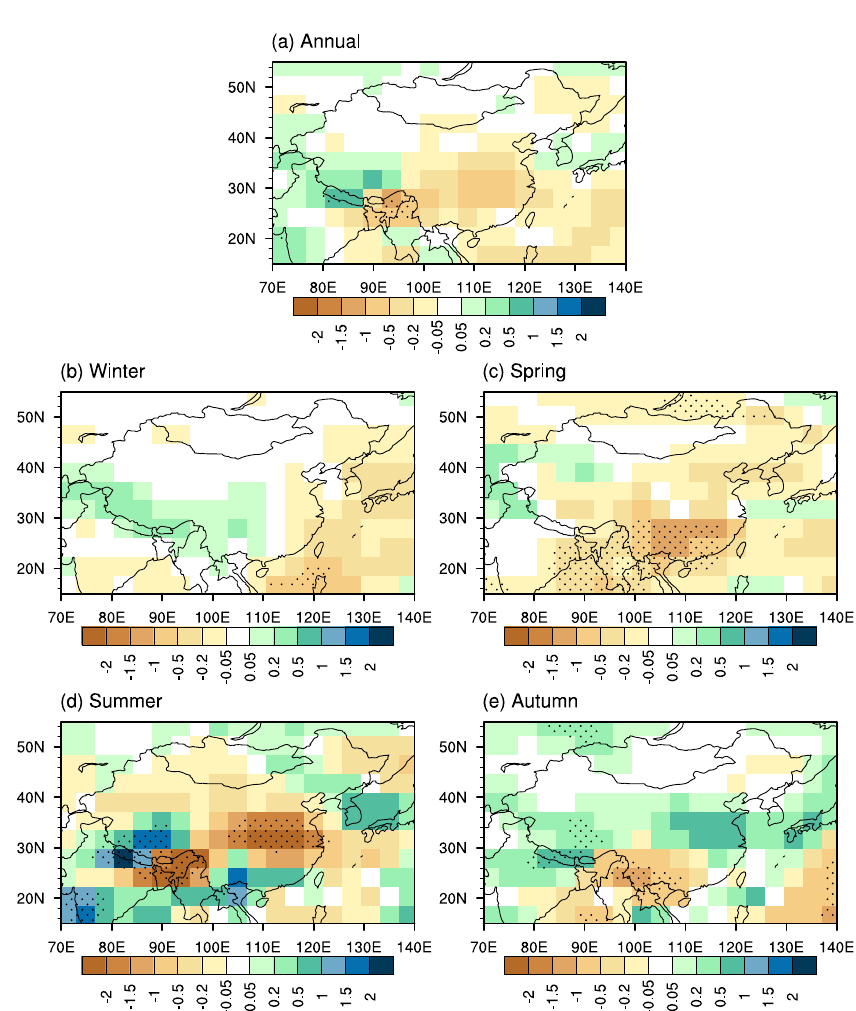
Fig. 7. Annual and seasonal precipitation changes (units:mmday − 1 ) between (AO(6ka)–AO(0ka)) and (A(6ka)–A(0ka)) experiments. The areas exceeding 90% confidence level are